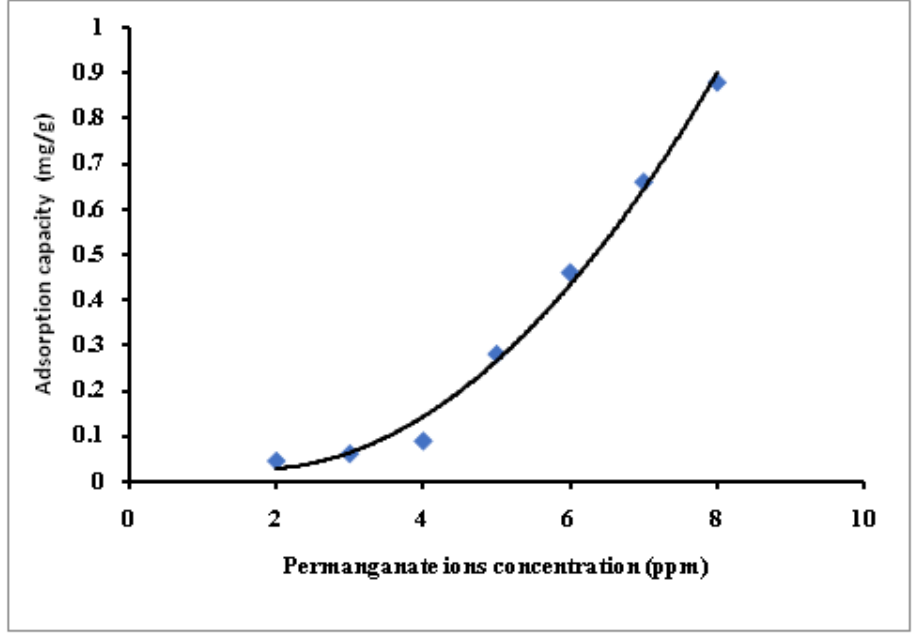
Figure 11. Effect of the permanganate metal ions concentration on the adsorption capacity of MB- SPGMA composite adsorbent.